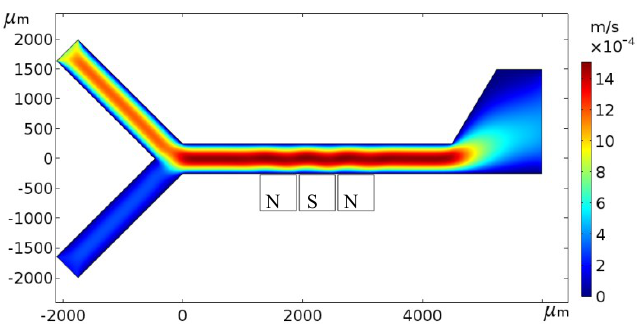
Figure 5. Velocity profile near the magnets.